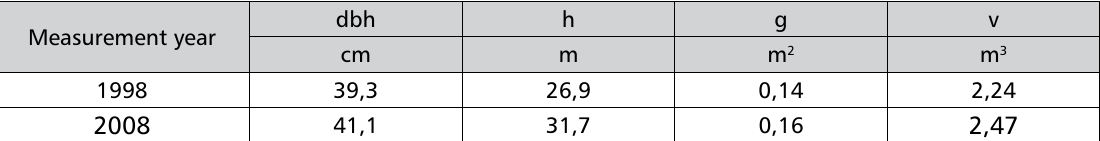
Average values of diameter at breast height, basal aera and volume of beech trees of both